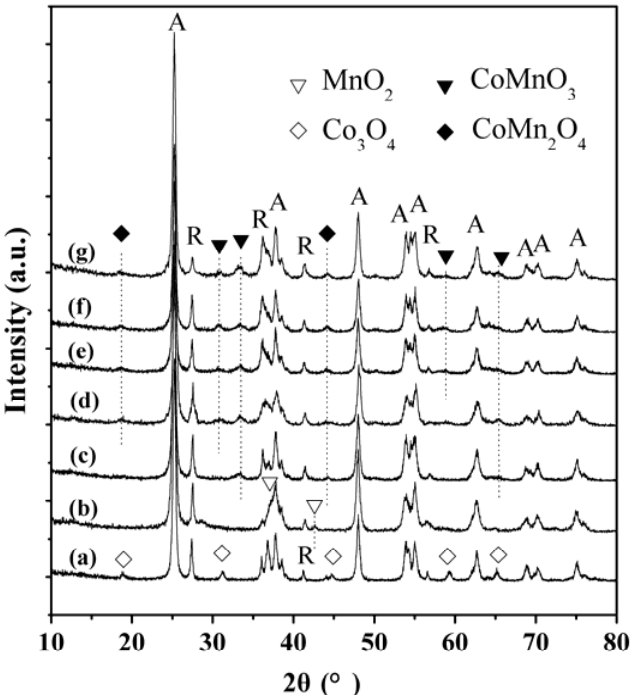
Figure 3. XRD patterns of the catalysts Mn ‐ Co/TiO 2 (773 K) with different Co contents: ( a ) 10Co/TiO 2 ; ( b ) 10Mn/TiO 2 ; ( c ) 10Mn ‐ 2Co/TiO 2 ; ( d ) 10Mn ‐ 5Co/TiO 2 ; ( e ) 10Mn ‐ 8Co/TiO 2 ; ( f ) 10Mn ‐ 10Co/TiO 2 ; and ( g ) 20Mn ‐ 10Co/TiO 2 . (A = anatase phase of TiO 2 , R = rutile phase of TiO 2 ).